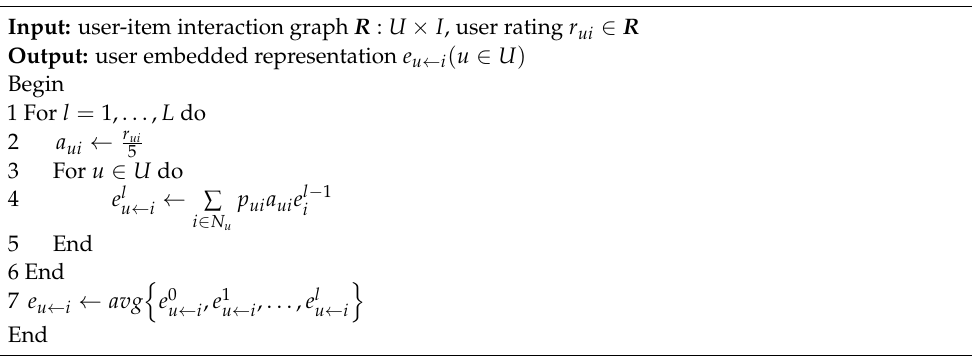
Algorithm 1 User embedding vector representation based on the user-item interaction graph